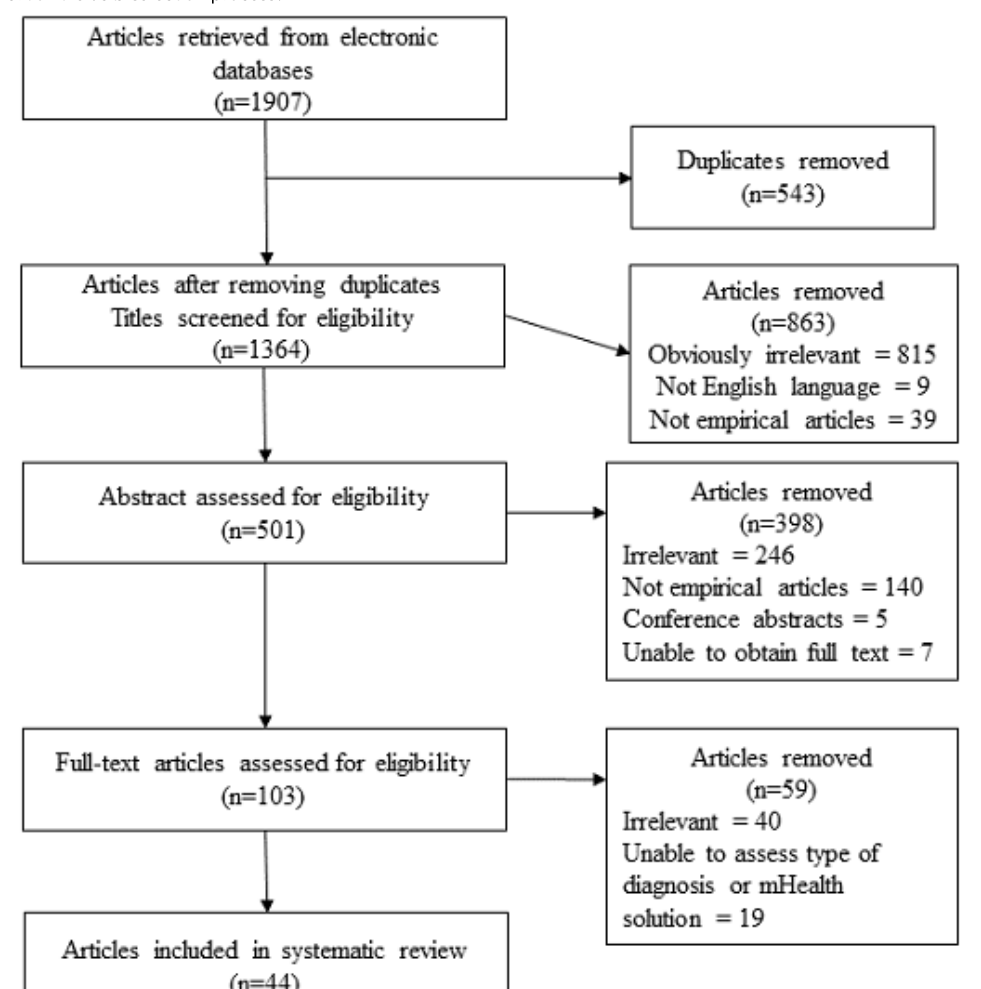
Figure 1. Flowchart of the data selection